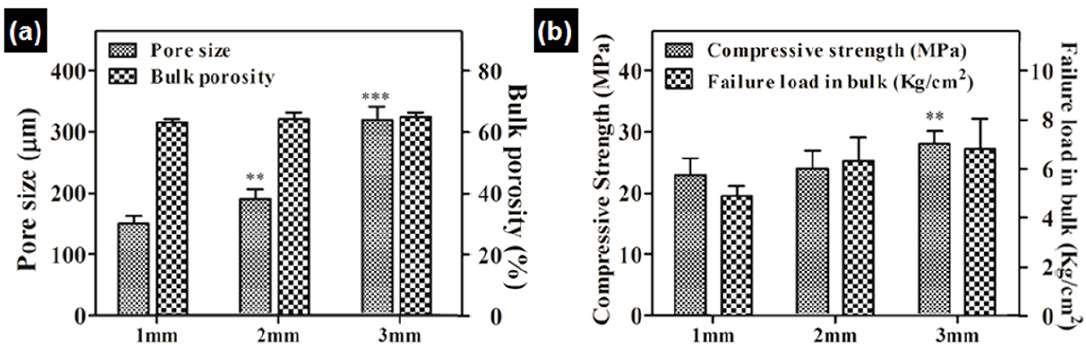
Figure 2. Physical and mechanical characterization of the granular bone substitute ( a ) pore size, ( b ) compressive strength. ** ≤ 0.01, *** ≤ 0.001 ( b ) compressive strength. ** ≤ 0.01, *** ≤